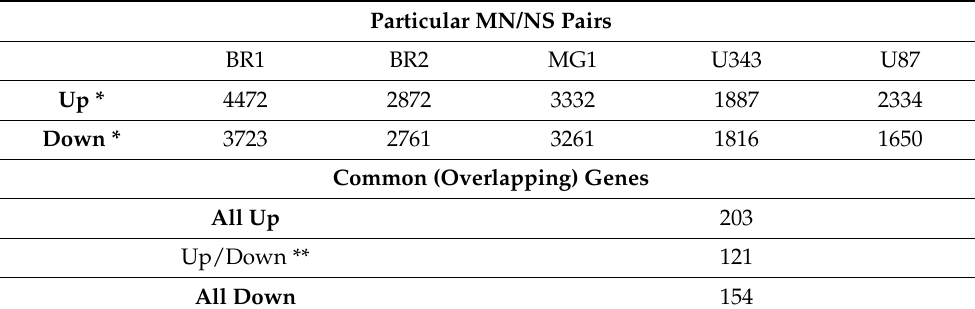
Table 2. Differentially expressed genes in MN/NS pairs of glioma cell cultures.